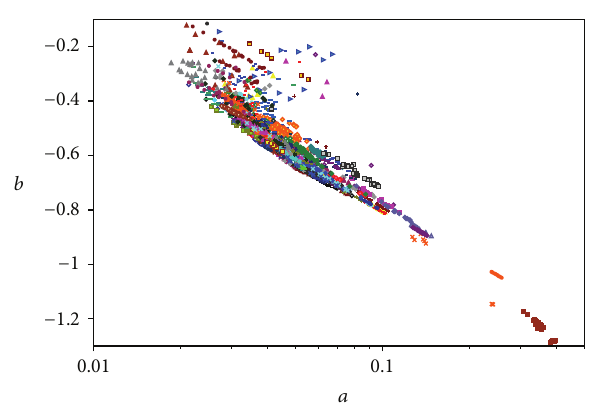
Figure8:PLregression locus (𝑎,𝑏) of24632-tupleHSRFsinDataset 2, including canonical protein sequences and